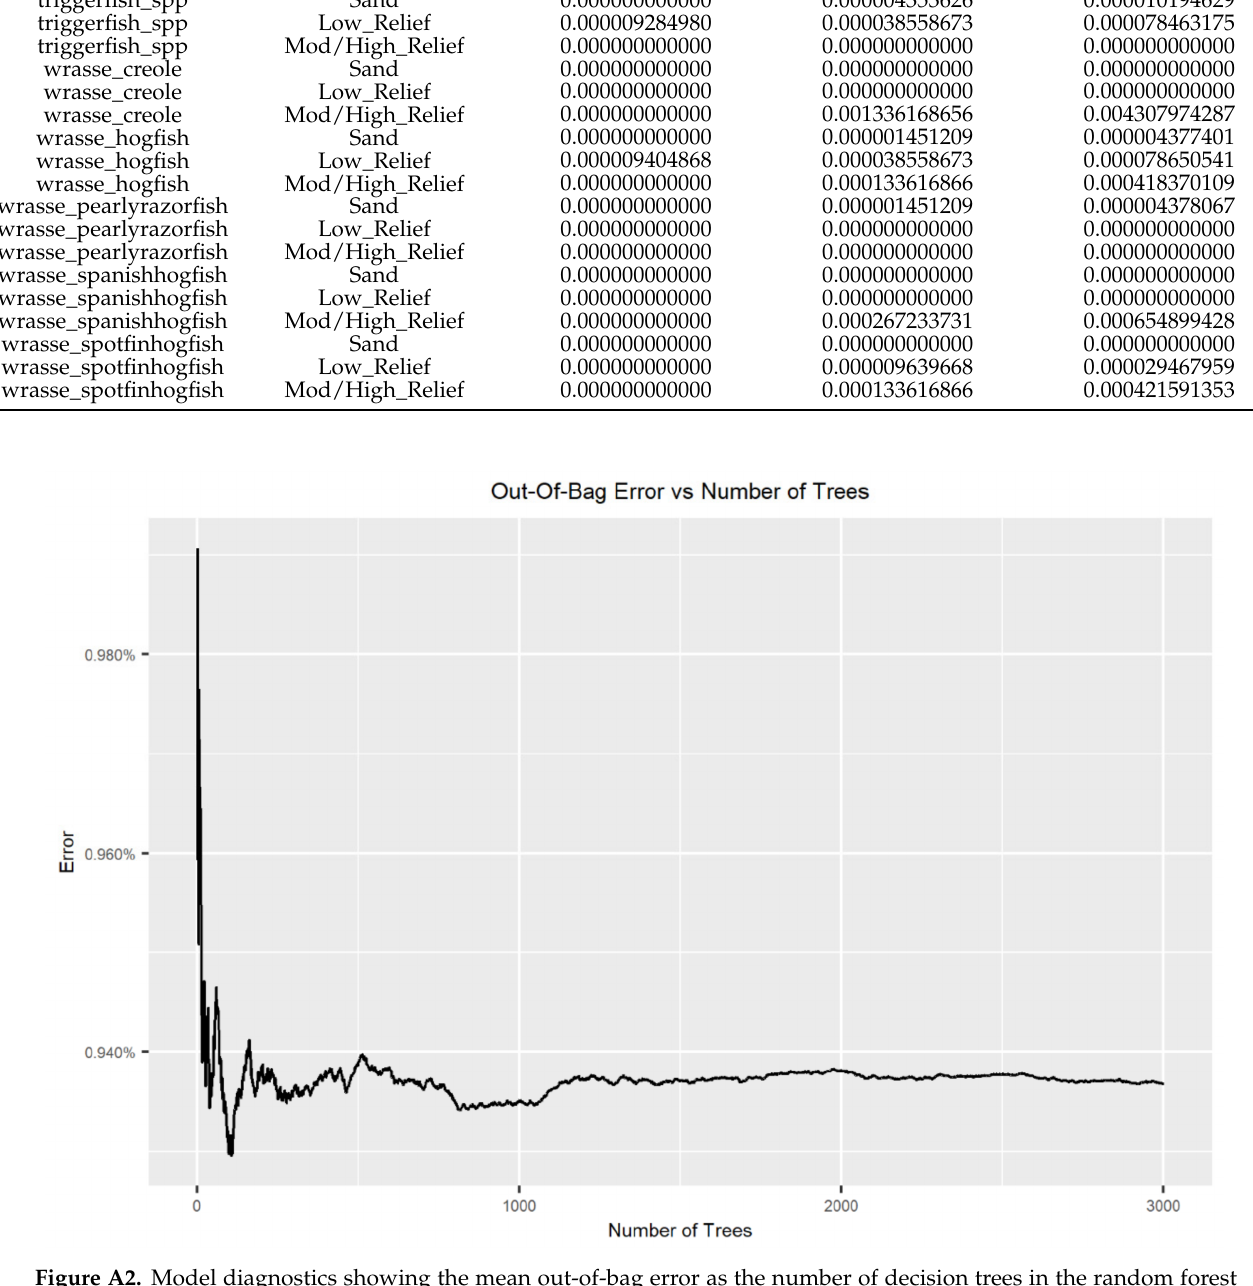
Figure A2. Model diagnostics showing the mean out-of-bag error as the number of decision trees in the random forest model increases. The error rate plateaus, meaning that a sufficient number of decision trees are used in the